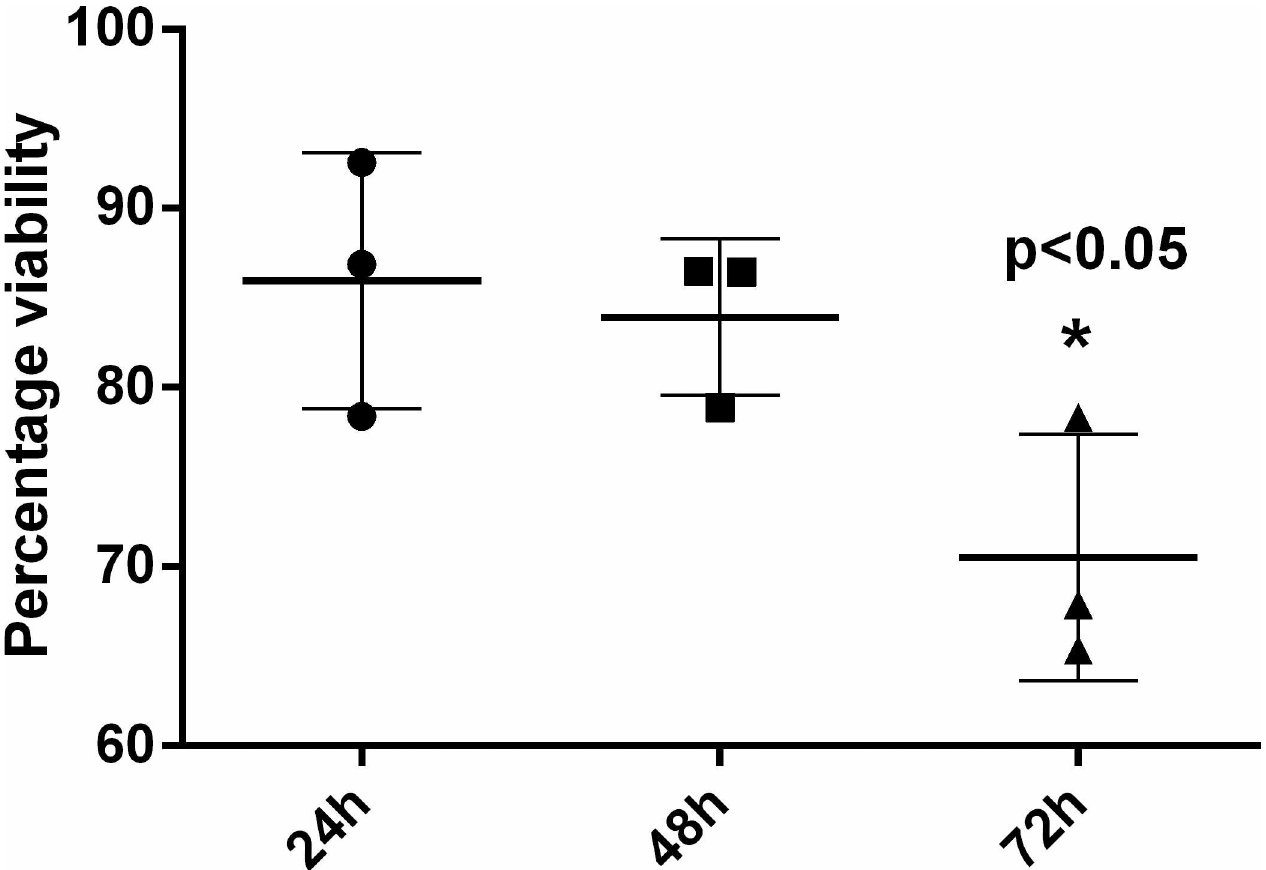
Fig 1. Percentage Viabilty of M . agalactiae -infected HeLa cells. Viable HeLa cells were measured using Trypan blue staining at 24, 48 and 72 h p.i. Mean values ± SD from three independent experiments performed in duplicates are depicted.